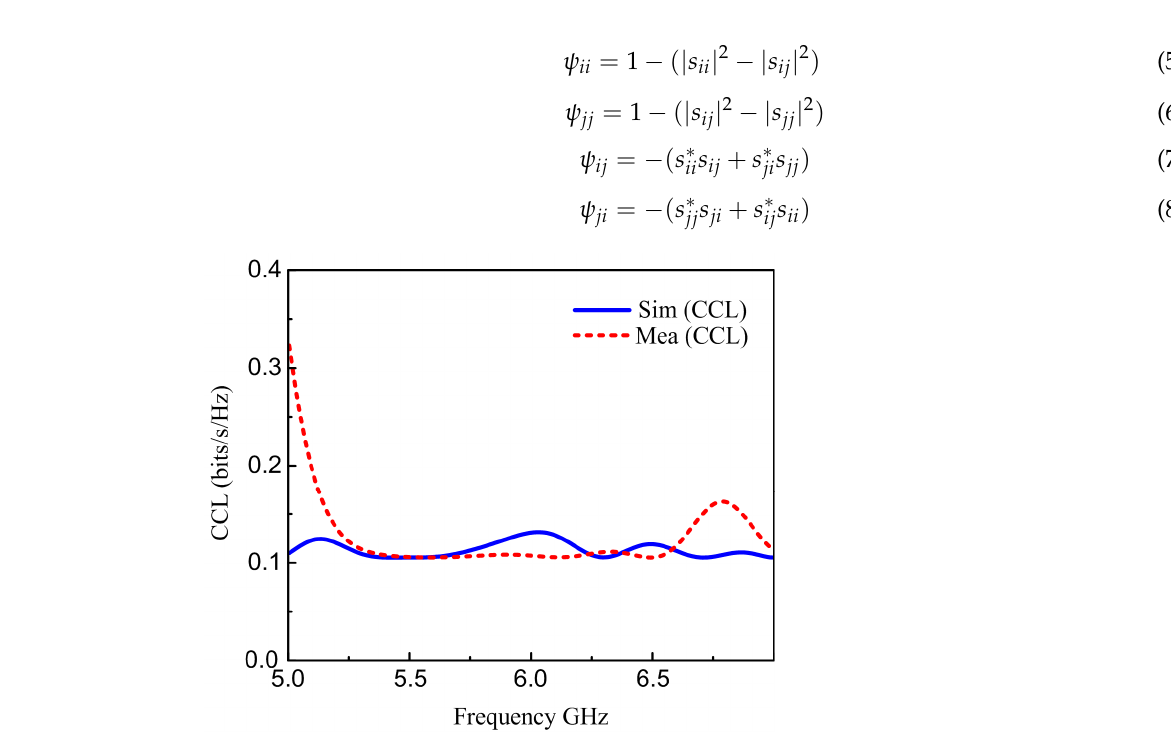
Figure 14. Simulated and measured